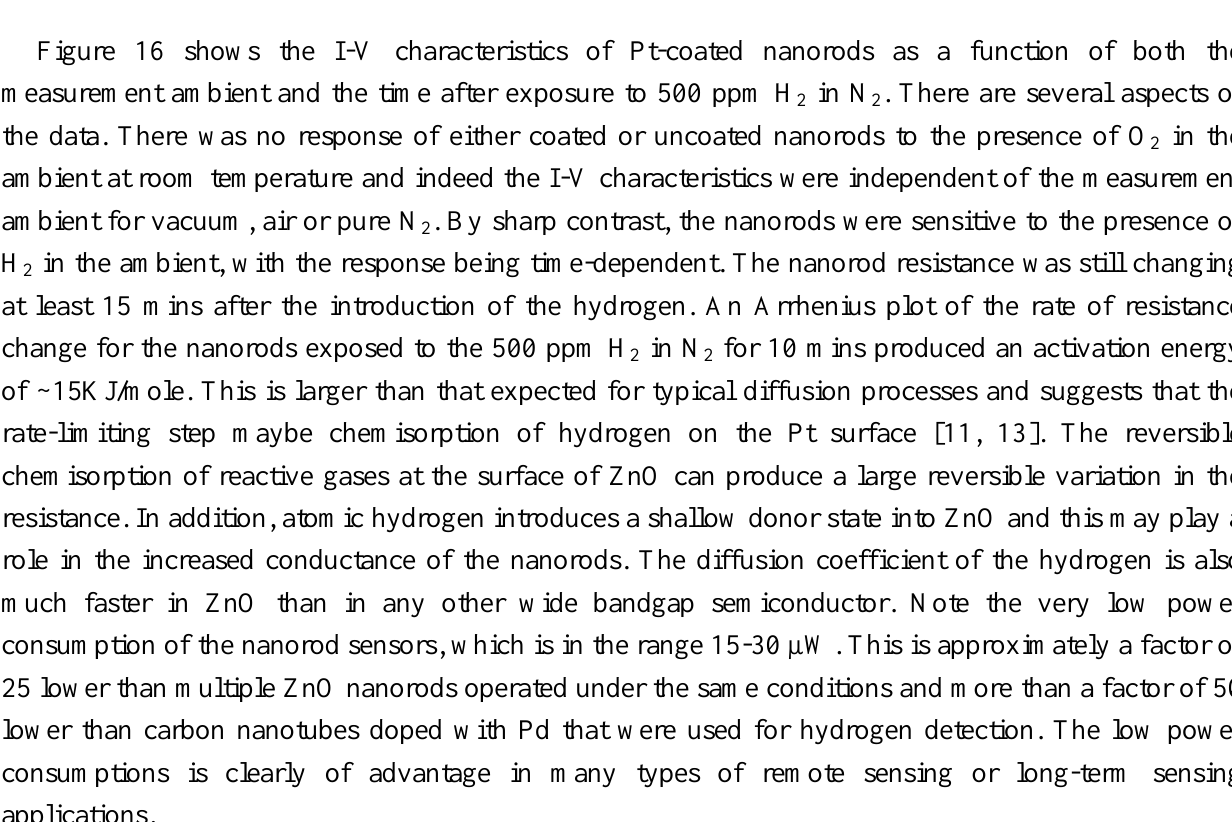
Figure 15. I-V plot of uncoated or Pt-coated single ZnO nanorods measured at room temperature in pure N 2